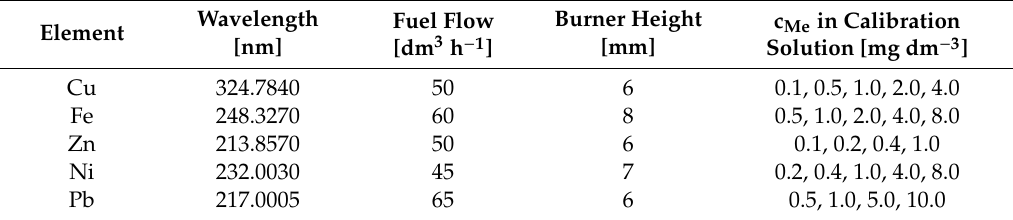
Table 1. Operating conditions of high-resolution continuum-source flame atomic absorption spectrometry (HR CS FAAS) for element